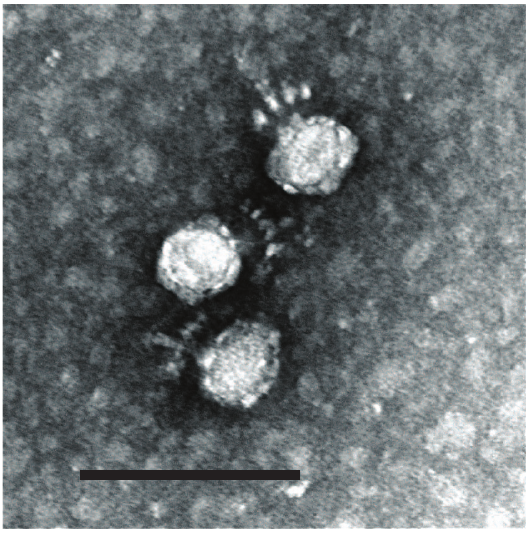
Figure 1. Electron Micrograph of Bacteriophage W CP7R. Scale bar represents 100